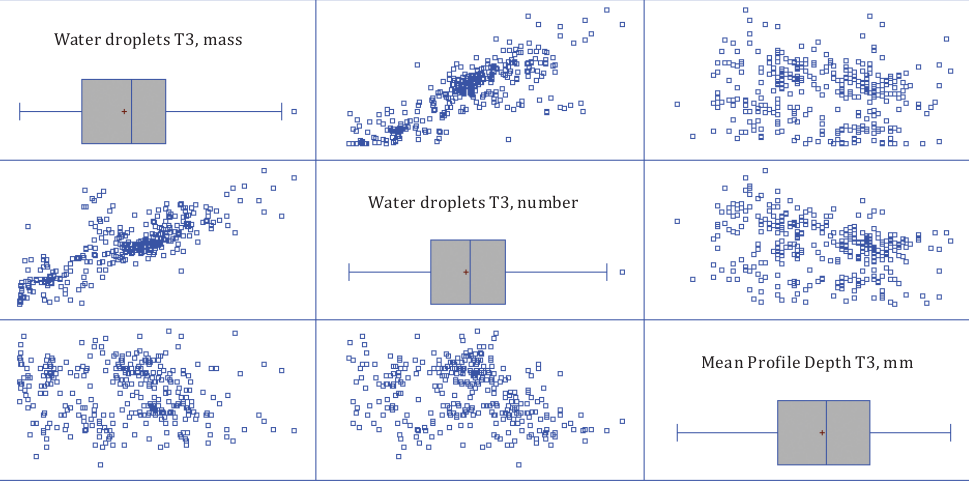
Water droplets T3, mass